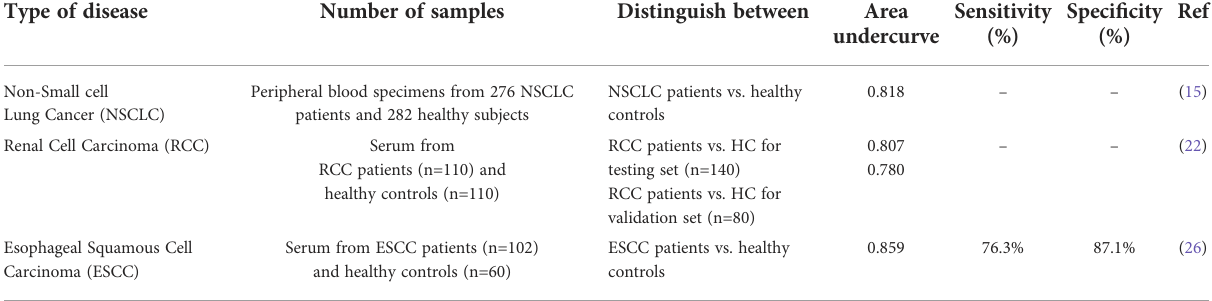
TABLE 2 Diagnostic value of miR-20b in